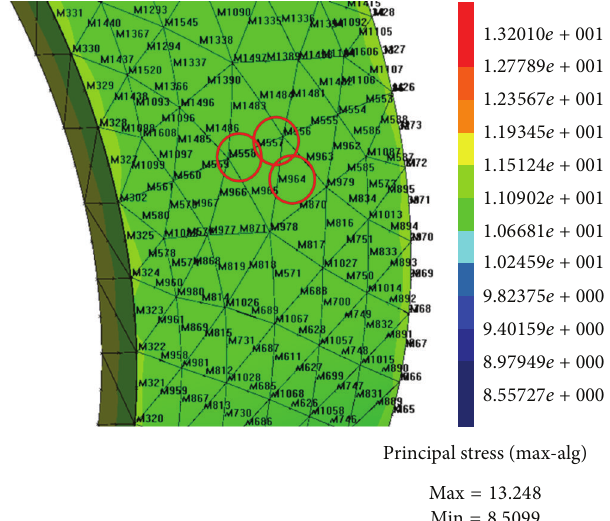
Figure 4: Stress distribution of an oil pipe bearing general metal loss.